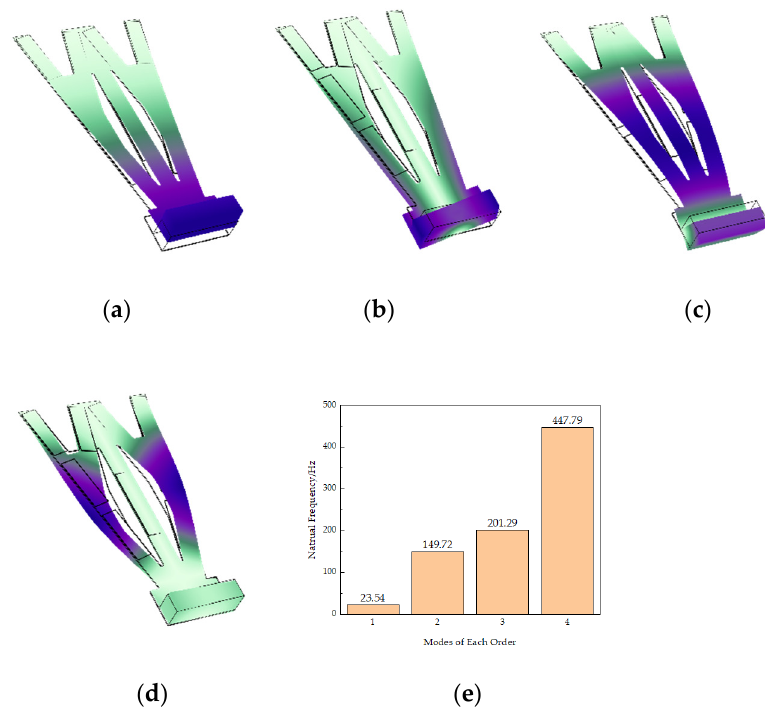
Figure 3. Various modes of the STTM-PEH ( a ) first-order mode; ( b ) second-order mode; ( c ) third- order mode; ( d ) fourth-order mode; ( e ) the natural frequencies of each mode of the